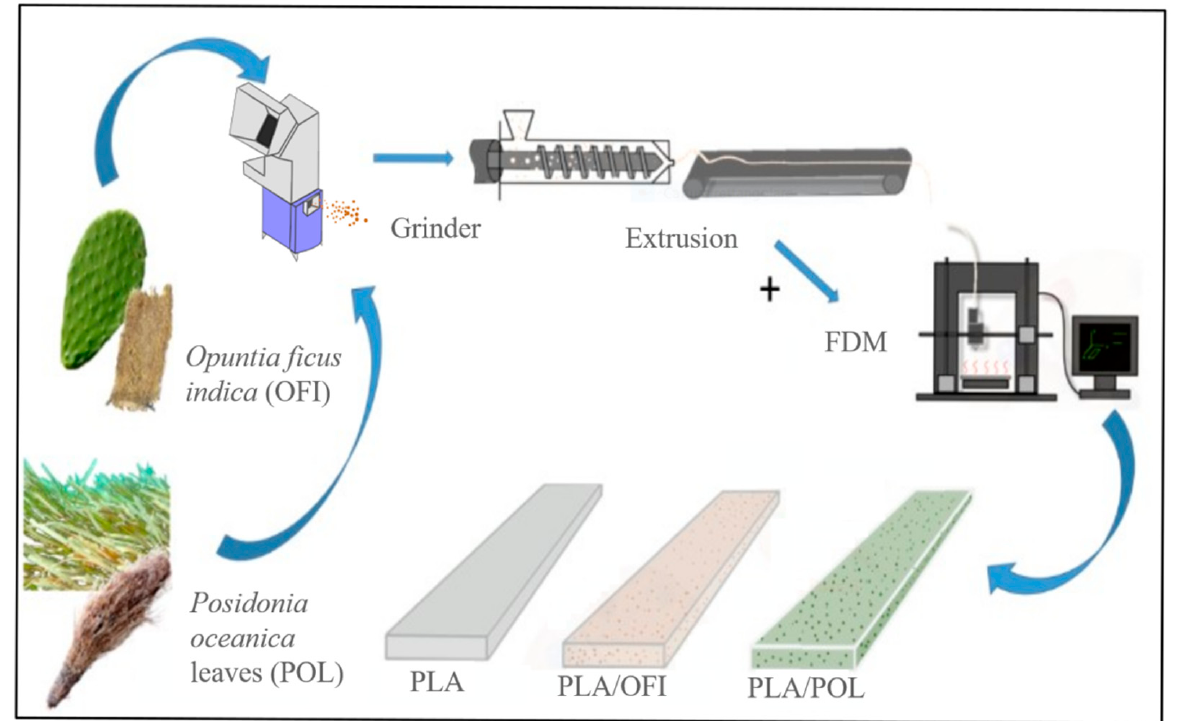
Figure 3. Schematic representation of the process.